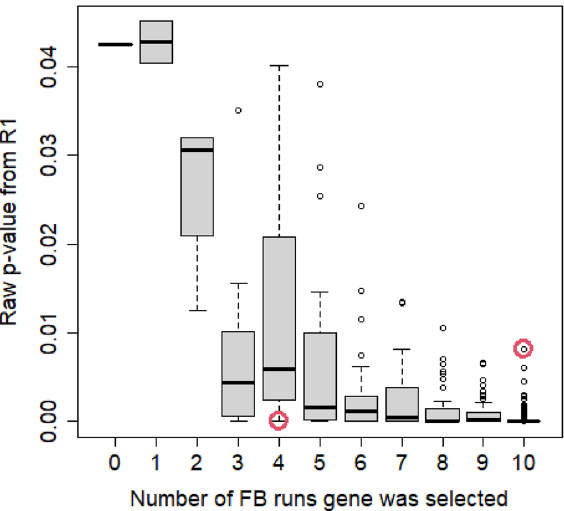
Figure 8. Raw it p values of 628 genes selected as differentially expressed by in the R1 data set versus number of runs with artificially replicates generated by the FB